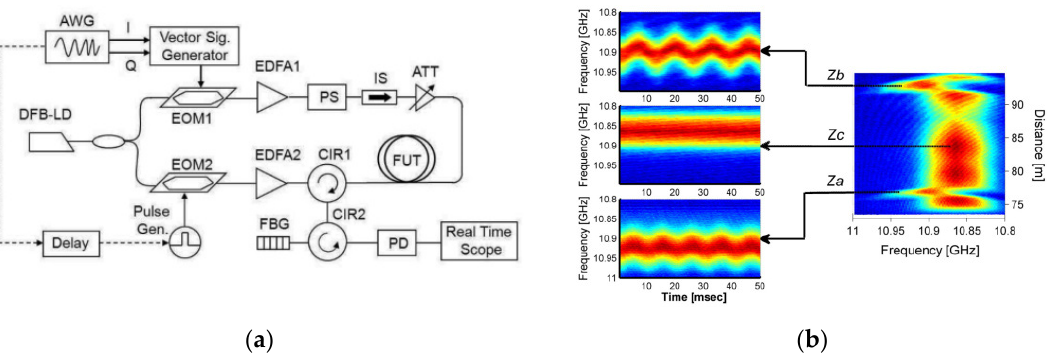
Figure 19. ( a ) Experimental setup for fast frequency sweeping BOTDA; ( b ) BGS acquired in one fixed and two vibrating locations of the FUT [67].